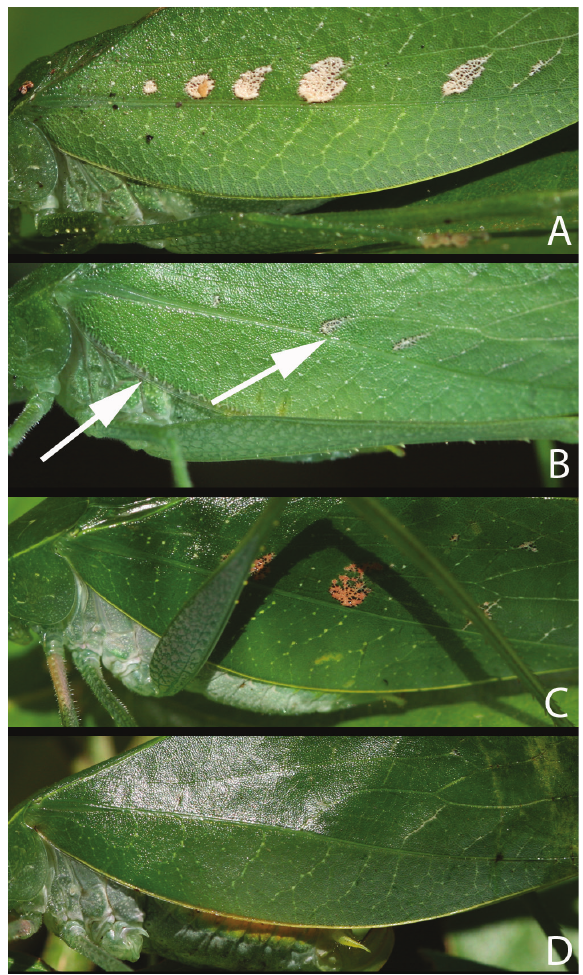
Figure 15. Left wings of male G. maculata ( A ), G. helleri sp. n. ( B ), G. immaculata ( C ) and female G. furcata sp. n. ( D ). Mor- phological differences beteen G. maculata and G. helleri sp. n. are small. However, usually G. maculata ( A ) have more and larger maculae on the tegmina while G. helleri sp. n. ( B ) have fewer maculae that are smaller and longish and usually start where Rs branches off (right arrow). Also G. helleri sp. n. has a white borderd costal margin with veins branching off white and thickened (left